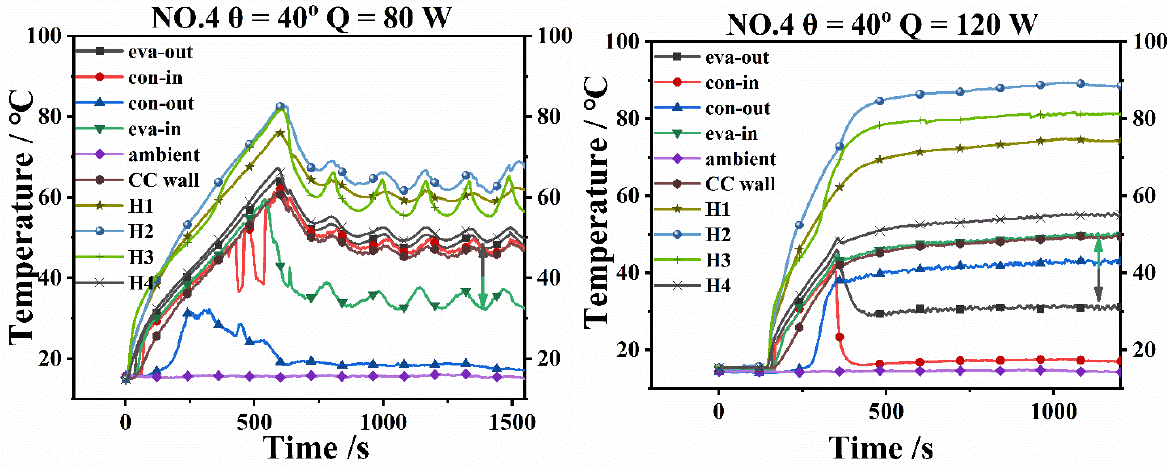
Figure 11. Temperature response during start up process of No.4 position at 80 W and 120 W.